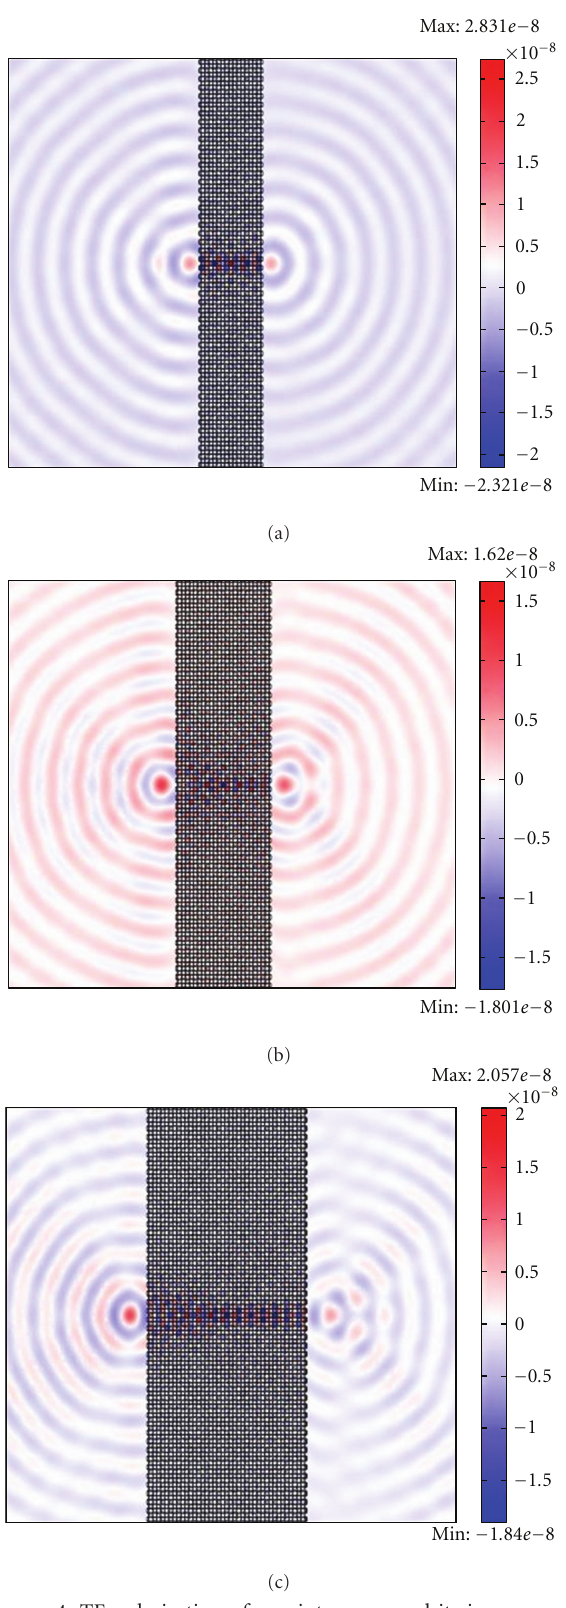
Figure 4: TE polarization of a point source and its image across a PhC slab of square lattice. The normalized frequency is ω = 0 . 211(2 πc /a ). (a) 8-layer PhC slab, (b) 12-layer PhC slab, and (c) 20-layer PhC